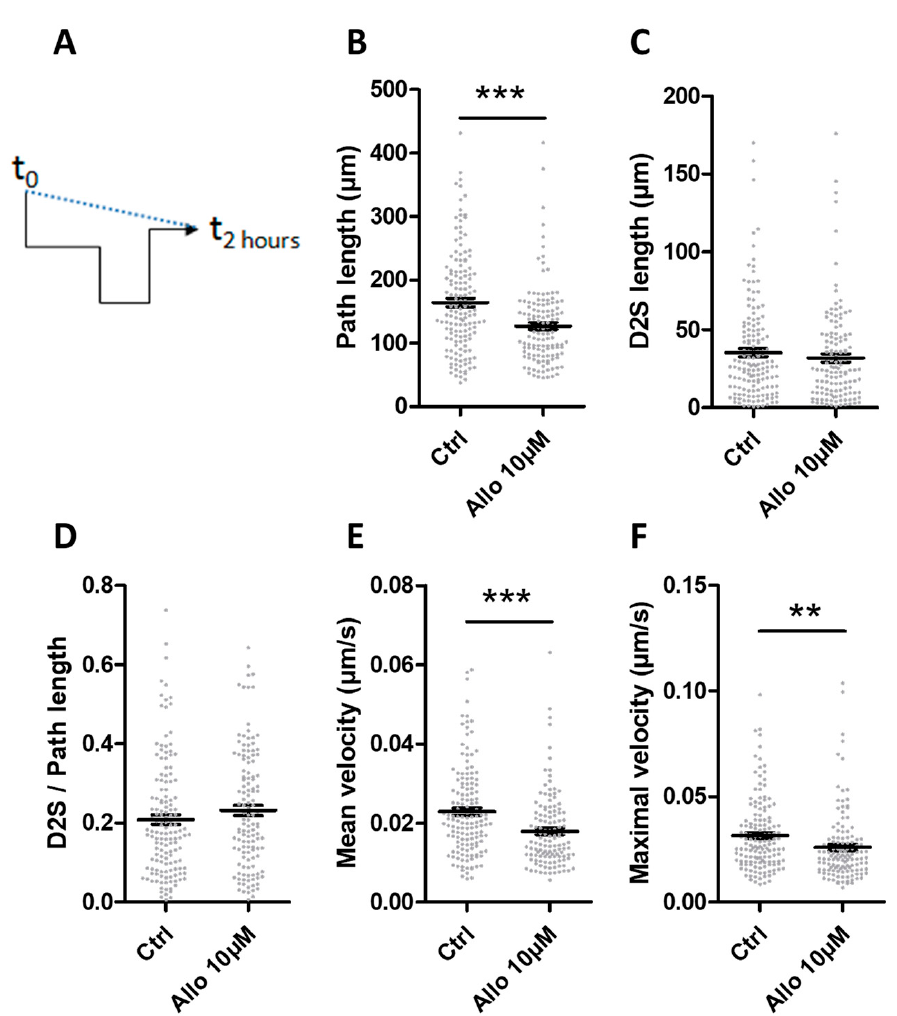
Figure 5. ALLO modifies the motility of BV-2 cells grown in a low concentration of serum. ( A ) The path length represents the total path traveled by the cells during the experiment (black line). D2S is the distance between the start and the end point (dotted blue line). ( B ) The path length and ( C ) the distance traveled between the first and the last position of the BV-2 cells (D2S length) were measured from time-lapse imaging. ( D ) The directionality (i.e., the ratio D2S length/path length), ( E ) the mean velocity and ( F ) the maximal velocity of BV-2 cells were subsequently determined. BV-2 cells were grown in 1% FCS. Mean values ± SEM are shown, with n = 146 control cells and n = 129 ALLO-treated cells, from four independent experiments, ** p < 0.01, *** p < 0.001.